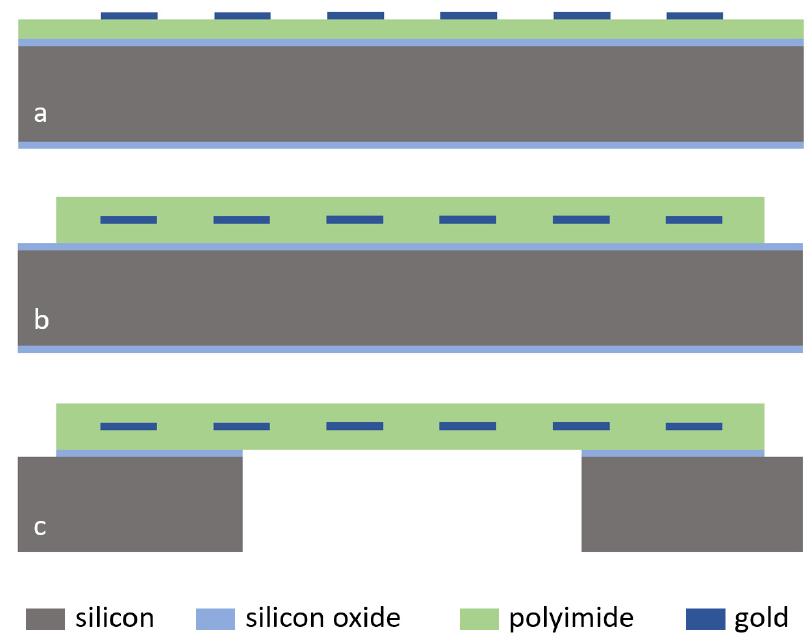
Figure 3. Microfabrication process flow: ( a ) thermal oxidation, polyimide coating and curing, gold deposition and structuring; ( b ) coating second polyimide layer after treatment of the first polyimide layer, structuring polyimide; ( c ) opening membrane using DRIE and oxide etching.